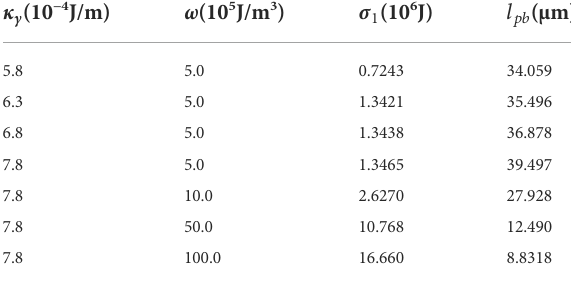
TABLE 2 Different κ γ and ω corresponding to different interfacial energy and interface width. σ 1 is the interfacial energy between γ phase and γ + β ( γ > ß )